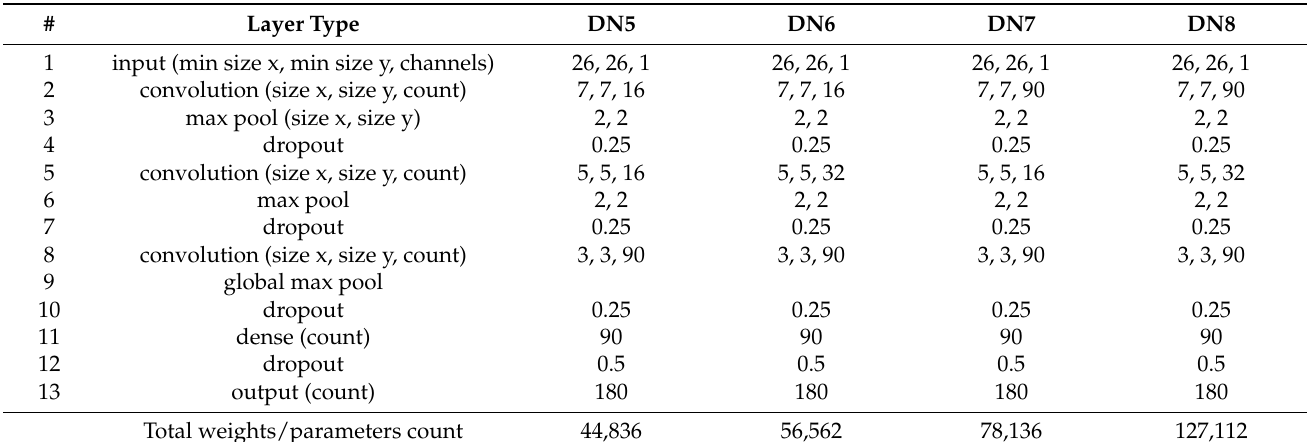
Table 3. The second four deep CNN